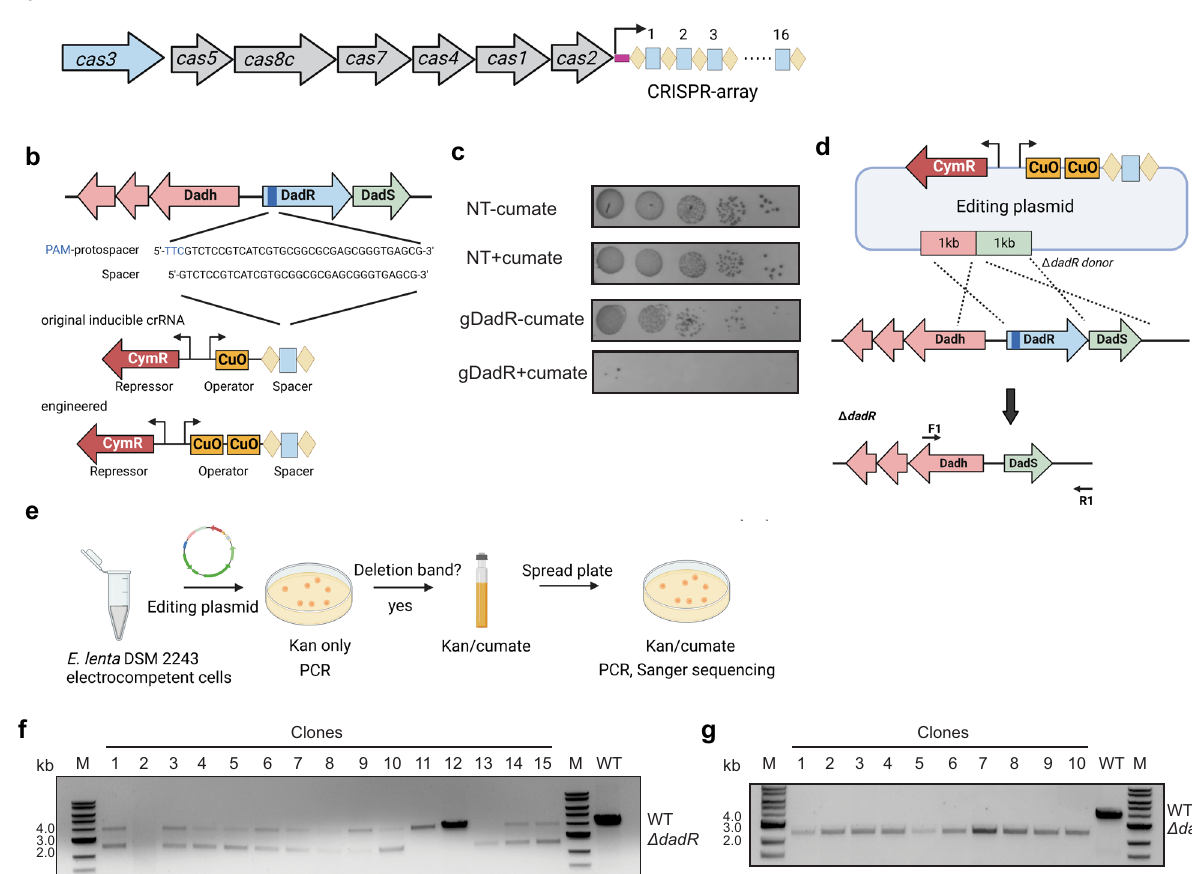
fl anking the repair template were used. e Work fl ow for generating the Δ dadR deletion strain. f PCR screening of colonies formed after initial pXD71Cas10.1RT transformation revealed most colonies contained both non-edited (4kb) and edited cells (2.5kb). g PCR screening of colonies formed after spreading initial pXD71Cas10.1RT transformant cultures onto a cumate-containing plate